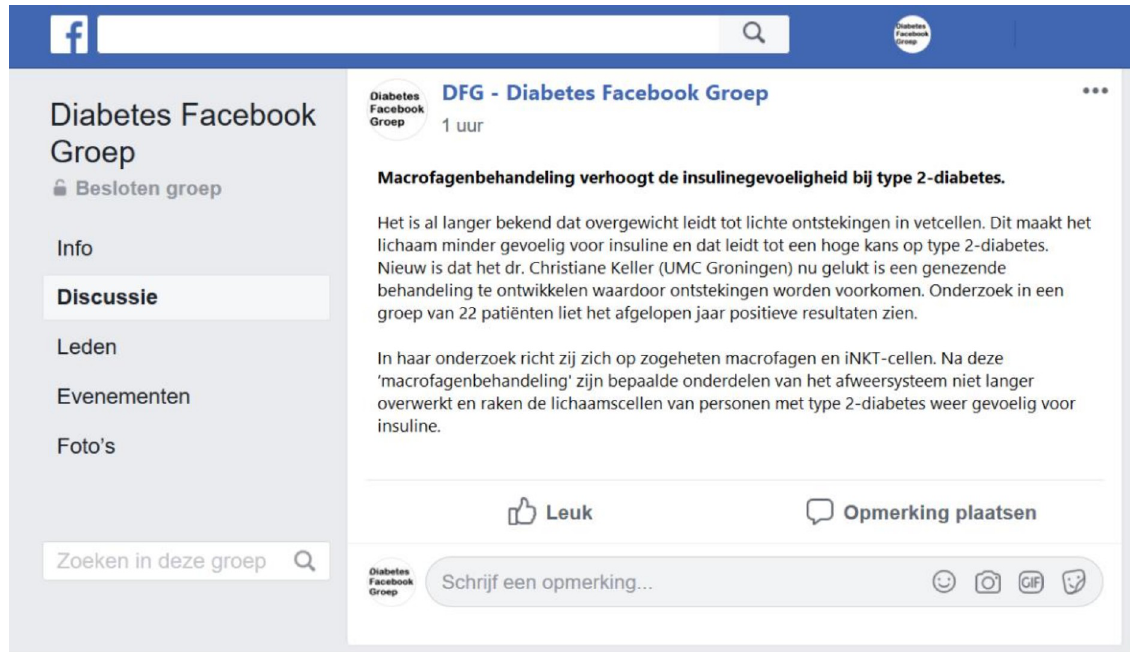
Fig 1. The visual frame surrounding the news message suggests that the news message is published in an online diabetes Facebook group.